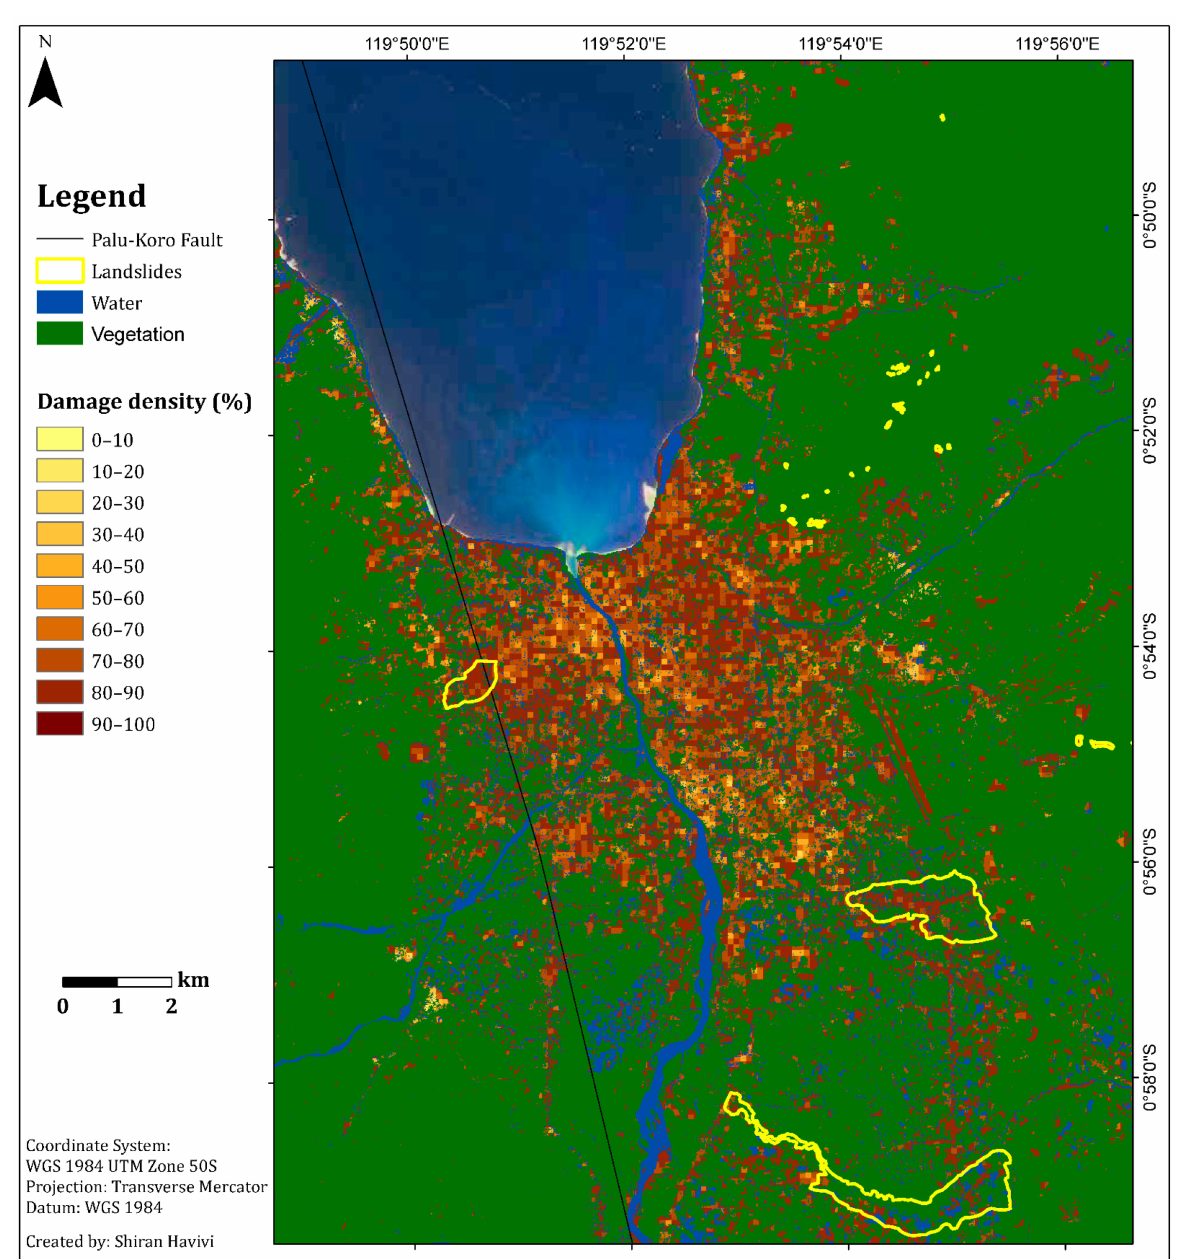
Figure A1. Damage assessment map generated from medium spatial resolution (MSR) images using Sentinel-1 and Landsat-8